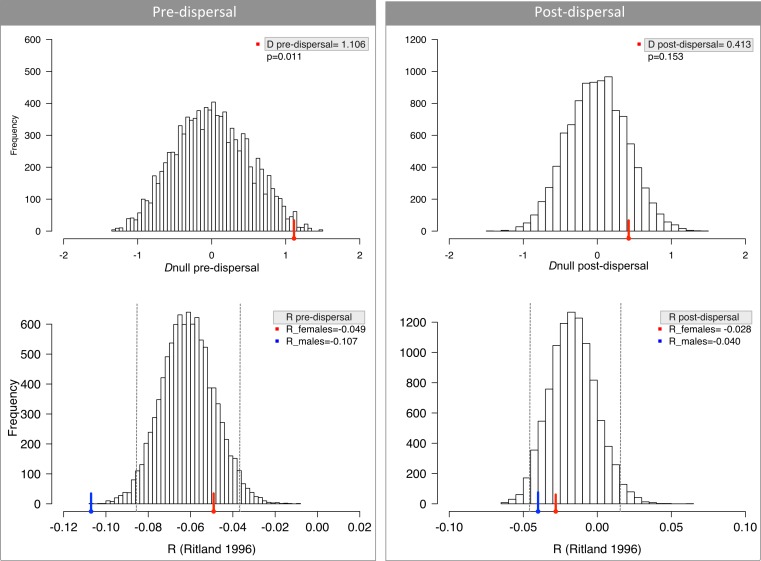
No difference in dispersal between males and females measured by relatedness (R) and difference in assignment index (D).Pre-dispersal group consists of young and juveniles and hence is a random assortment of alleles from all parents. Post-dispersal group comprises exclusively adults and therefore represents the populations after the movement of alleles due to dispersal. Dashed lines depict the 95% CI around mean R.